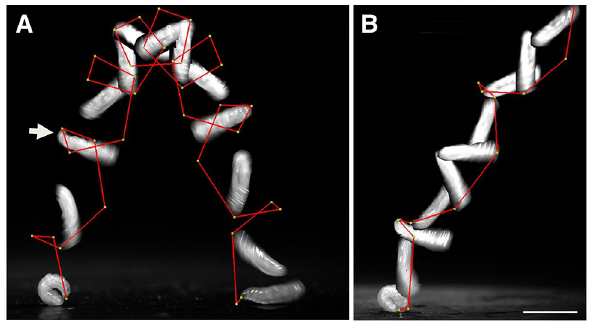
Figure 3. Jumping Ceratitis larvae rotate in backward somersaults along a ballistic trajectory. ( A ) Stop motion images taken from a steep but short ballistic jump overlaid with the positions of the mouth hooks (green dots) in selected frames. Positions between frames were deduced (red line). Head and mouth hooks are bent forward (thick arrow). ( B ) Less steep take-off angles result in longer jump distances. Scale bar 5 mm.